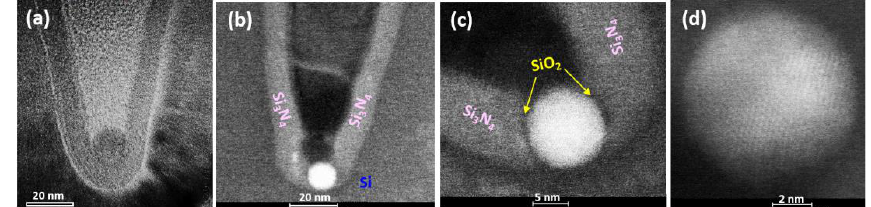
Figure 6. Plan-view TEM/STEM observations of the process evolution of Ge QDs formed at the included-angle locations of the asterisk-shaped Si 3 N 4 /Si ridges undergoing thermal oxidation at 900 ◦ C for ( a ) 30 min and ( b ) 40 min. High-resolution STEM observation of ( c ) Ge QD with a conformal SiO 2 shell penetrating the spacer layer of Si 3 N 4 . Clear lattice fringes shown in ( d ) high- resolution STEM micrograph are testament to the good crystallinity of the Ge QDs embedded within the Si 3 N 4